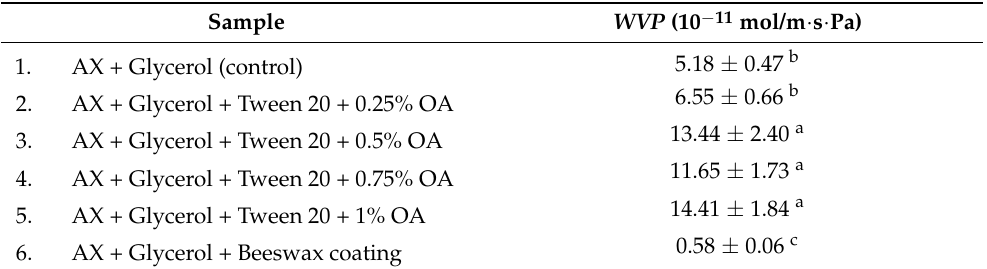
Table 7. Water vapour permeability ( WVP , 10 − 11 mol/m · s · Pa) of all the film samples. Values in the same column followed by different superscript letters differ significantly ( p <